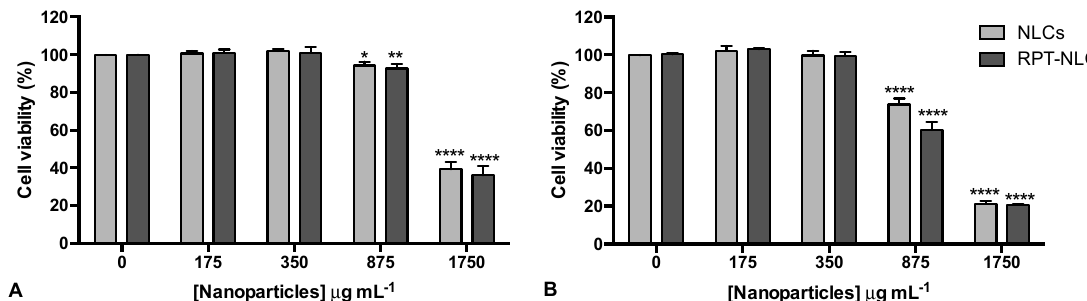
Figure 4. Primary human macrophage viability. Cells were exposed to RPT-NLCs and corresponding placebos at different concentrations (ranging from 0 to 1750 μ g mL − 1 ). Cell viability was measured using the resazurin reduction assay after ( A ) 1 d and ( B ) 7 d. Metabolic activity was normalized to untreated cells of the same donor and time point. Data are expressed as mean ± standard deviation (n = 3). Statistical comparisons of the means were performed using the two-way analysis of variance and differences between groups compared using Tukey’s multiple comparisons test. * p < 0.05, ** p < 0.01, **** p < 0.0001 compared to untreated cells.